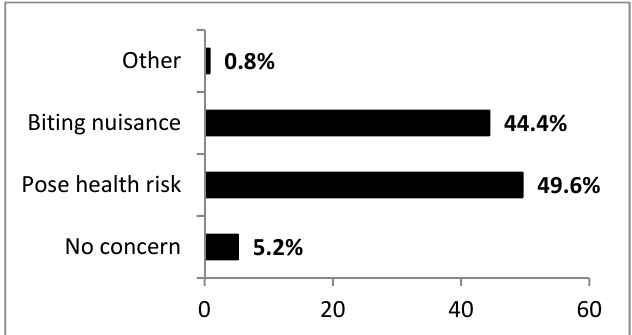
Figure 4. A summary of community concerns on the public health significance of mosquitoes across localities.